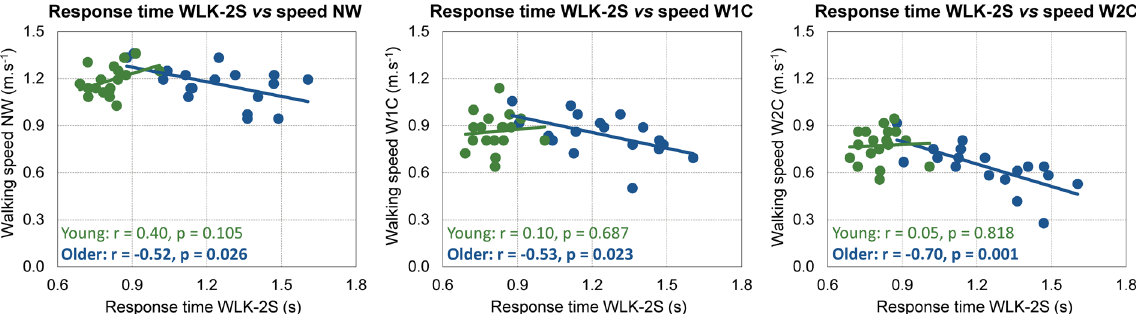
Figure 5. Pearson correlation coefficient different response time conditions ( x axis ) and overground walking speed ( y axis ) for younger ( green dots and trend lines ) and older adults ( blue dots and trend lines ). The response time to double stimuli during walking (WLK-2S, lower row ) was correlated to the walking speed during walking at preferred speed (NW, left ), at preferred speed while following pre-established clues on the floor (W1C, middle ) and at preferred speed while having to step only on the correct color (W2C, right ). Pearson correlation coefficient (r) and significance level (p) are shown for each